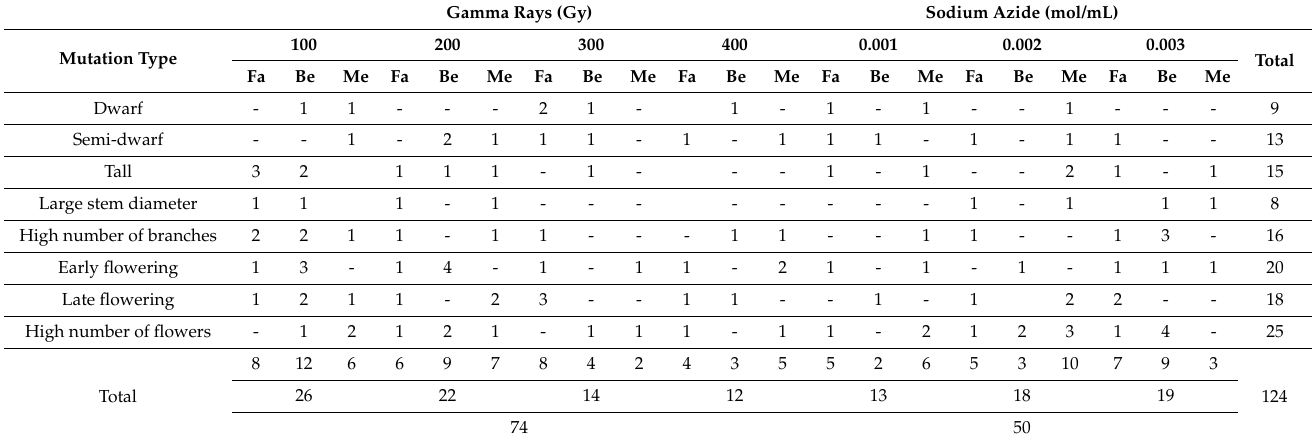
Table 1. The number and kind of different mutants produced by gamma rays and sodium azide in M 2 generation of the three German chamomile populations: Fayoum (Fa), Benysuif (Be), Menia (Me). Gamma Rays (Gy) Sodium Azide